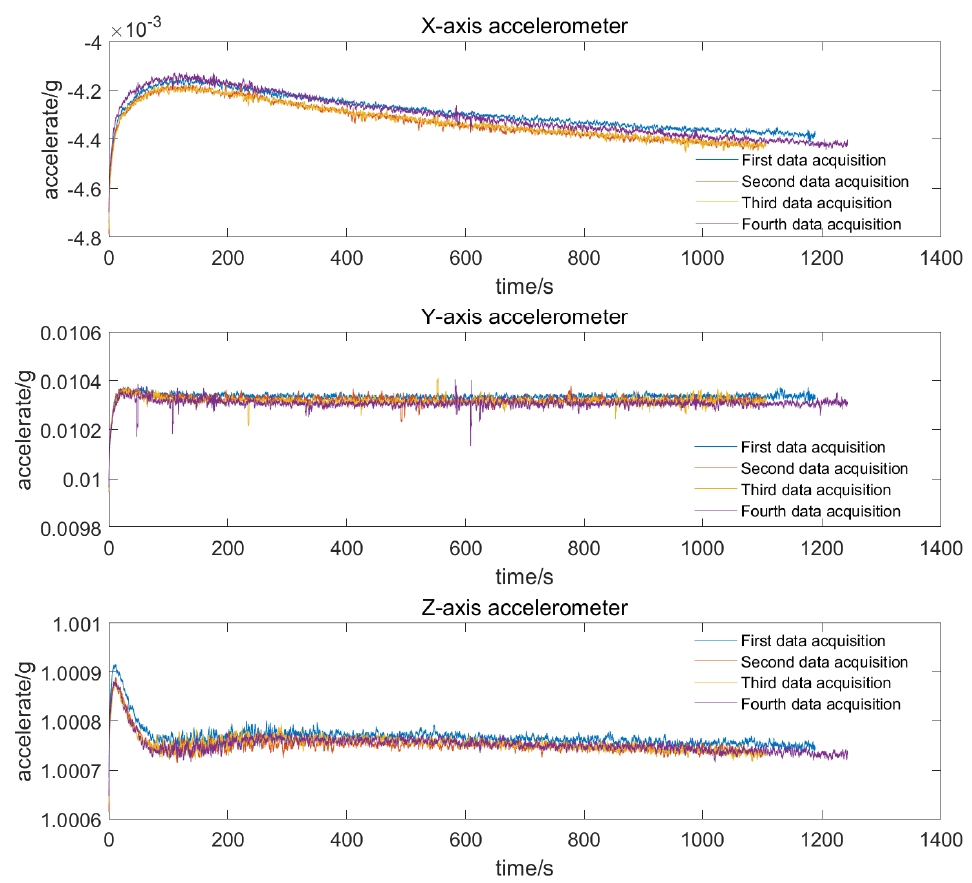
Figure 2. The experimental results for cold start-up phase of three-axes